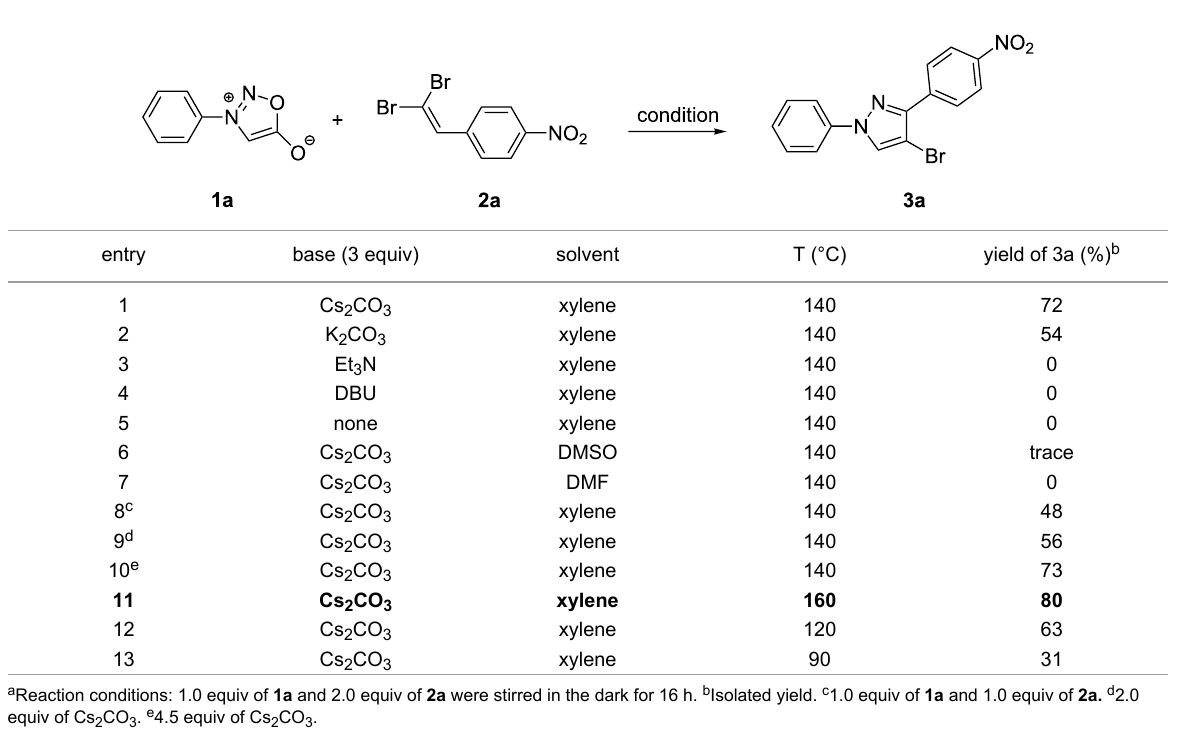
Table 2: Synthesis of 1,3-diaryl-4-halo-1 H -pyrazoles 3 . a